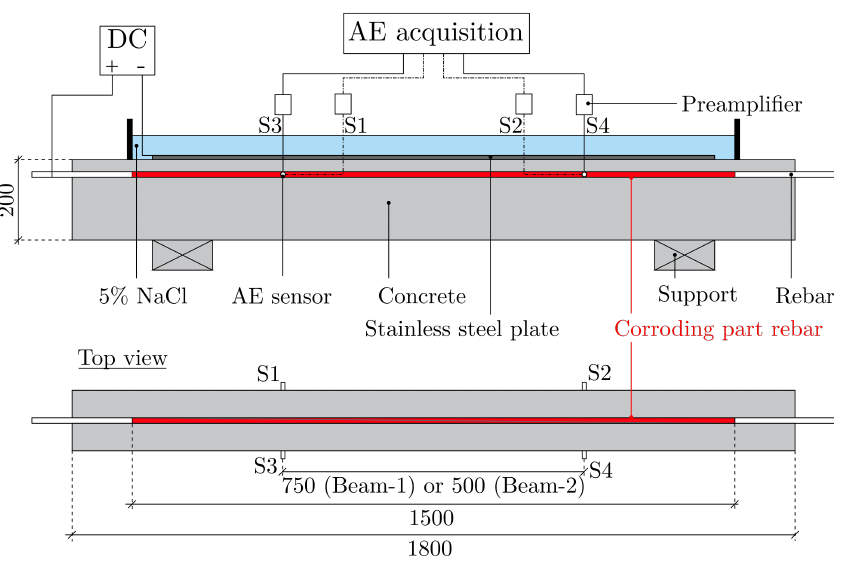
Figure 7. Schematic representation of the accelerated corrosion setup and 2D AE sensor configuration (S1–S4) of the first test series of RC beams (Beam-1 and Beam-2). For the second test series, two RC beams with dimensions 150 × 220 × 3000 mm 3 were cast. Two longitudinal rebars with a diameter of 14 mm were used in the tension zone, whereas two longitudinal rebars with a diameter of 12 mm were used in the compression zone. Additionally, stirrups having a diameter of 6 mm were spaced 120 mm at the center and 100 mm beyond. The concrete cover of the longitudinal rebars was 30